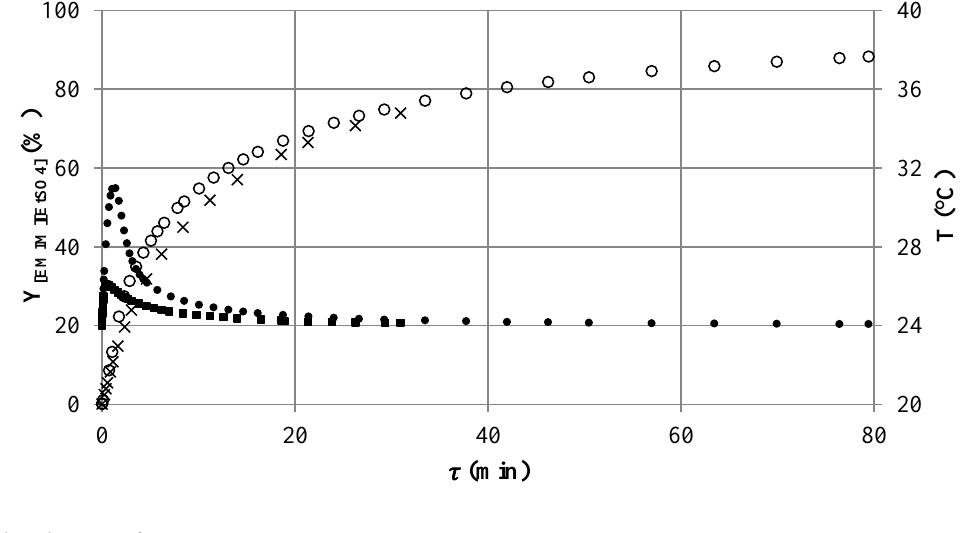
Figure 7. Simulated axial yield of [EMIM]EtSO (1,5) ( ∘ ) and SMX8 (1,5) (×) and corresponding temperature profile in reactor setups CT6 (1,5) ( • ) and SMX8 (1,5) ( ■